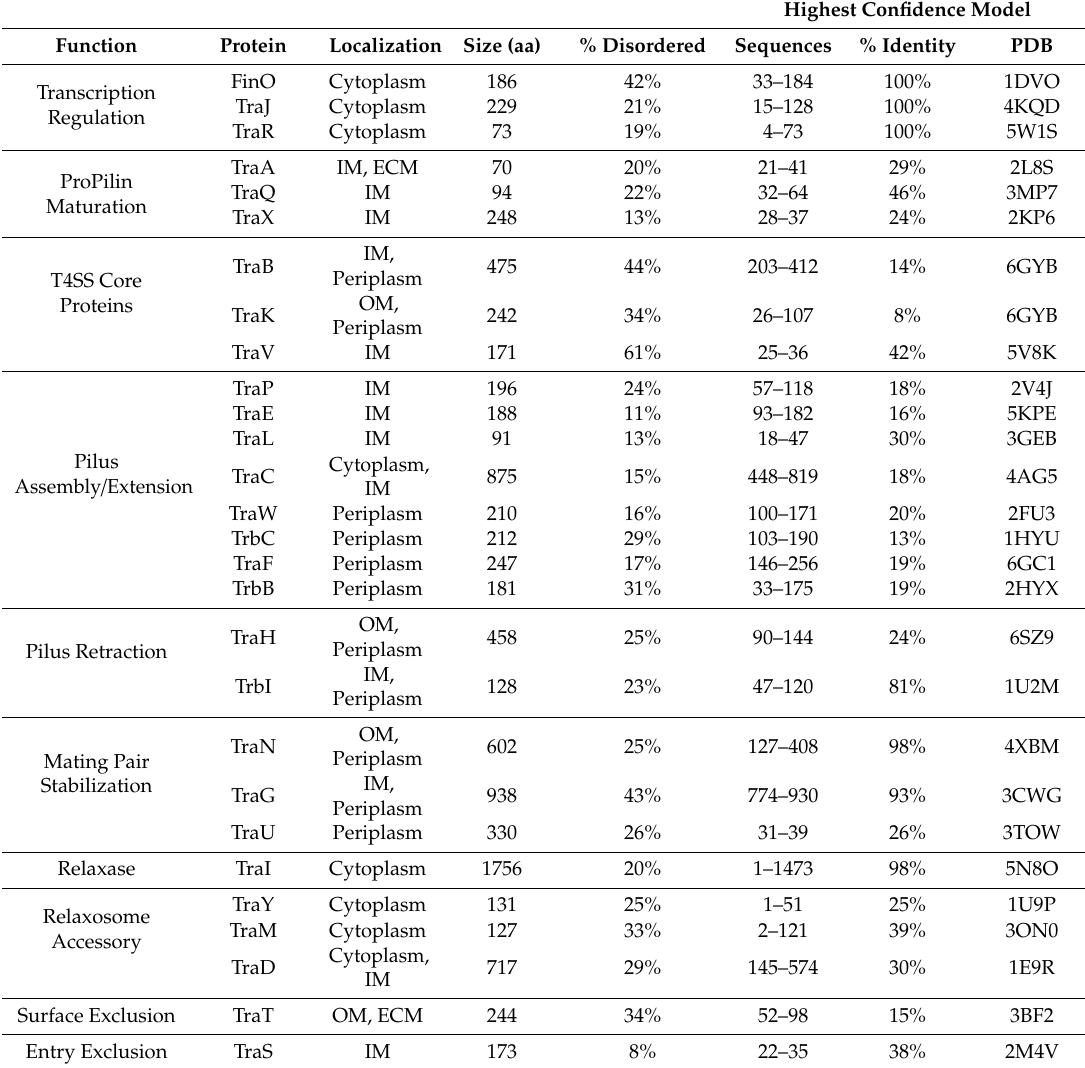
Table 1. Predicted Structural Dynamics of T4SS Transfer Proteins of the F Plasmid